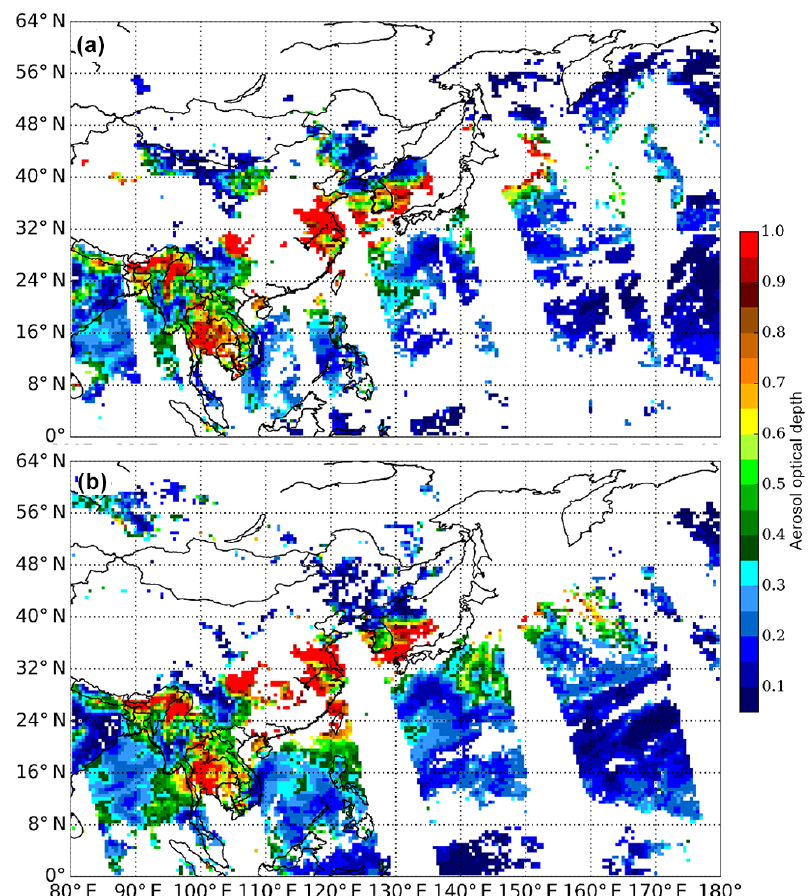
Figure 9. (a) MODIS Level 2 AOD retrievals and (b) VIIRS AOD retrievals for the 18 March 2014 case study presented in Sect. 4.1. The MODIS and VIIRS AOD retrievals are regridded onto identical domains for comparison purposes.